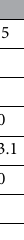
Table 2. Quarter lobule dimensions adapted from Nishii et al 28